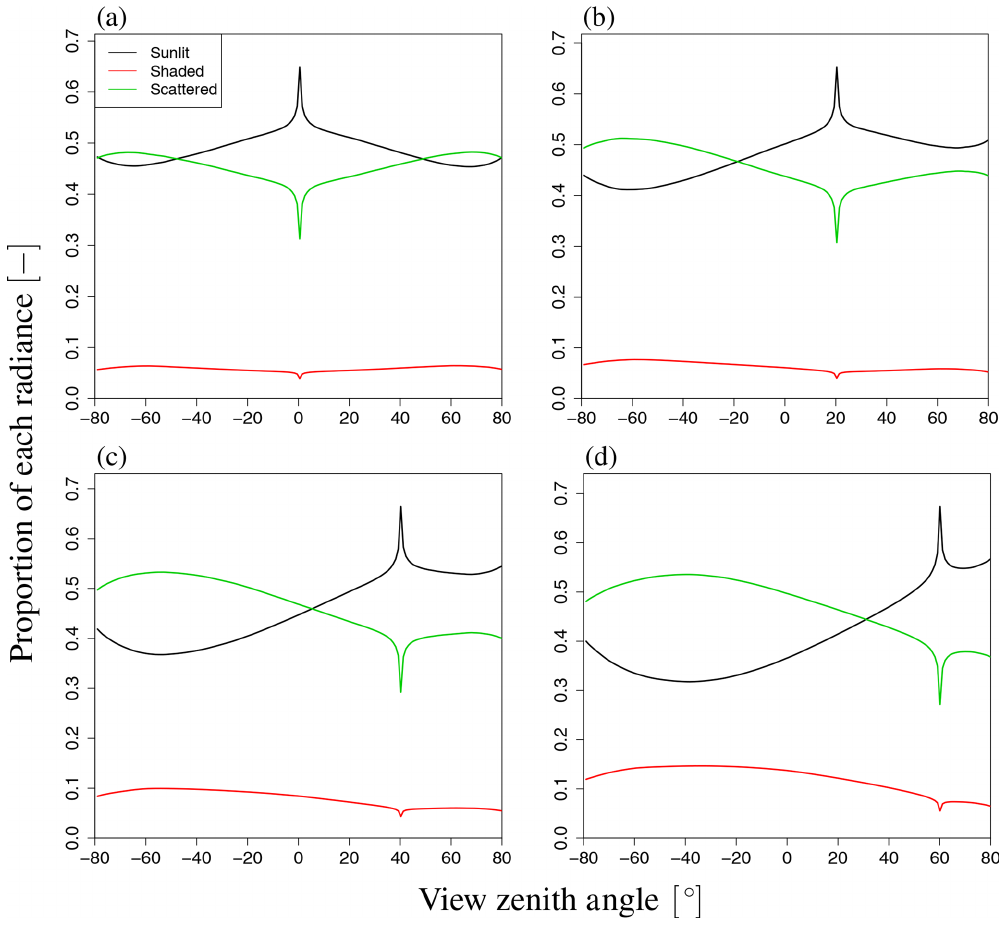
Figure 12. Proportion of SIF radiance with respect to VZA variation. Each figure shows the result under a different SZA value: (a) 0 ◦ , (b) 20 ◦ , (c) 40 ◦ , and (d) 60 ◦ . The contribution of shaded leaves is basically small, and the contribution rates of the other two radiances exhibit some angular dependency. In the backward direction, the contribution of scattered radiation to SIF is greater than that in the forward